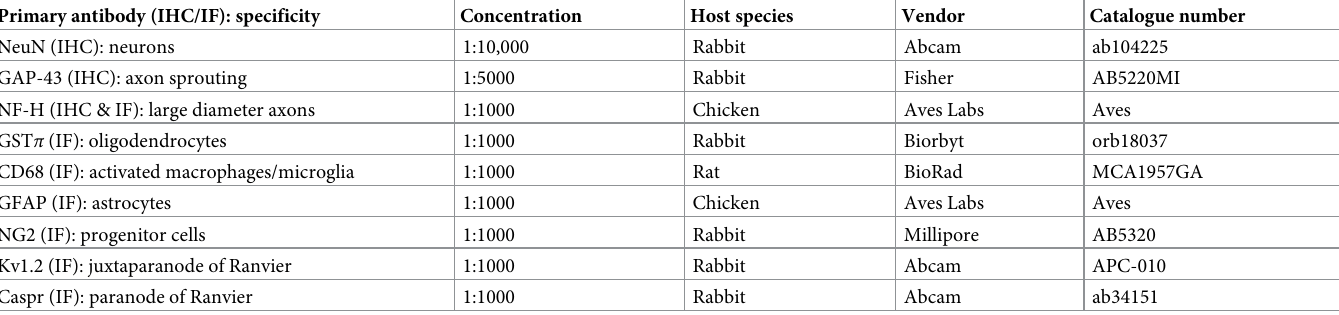
Table 1. List of primary antibodies used in this study. Primary antibody (IHC/IF): specificity Concentration Host species